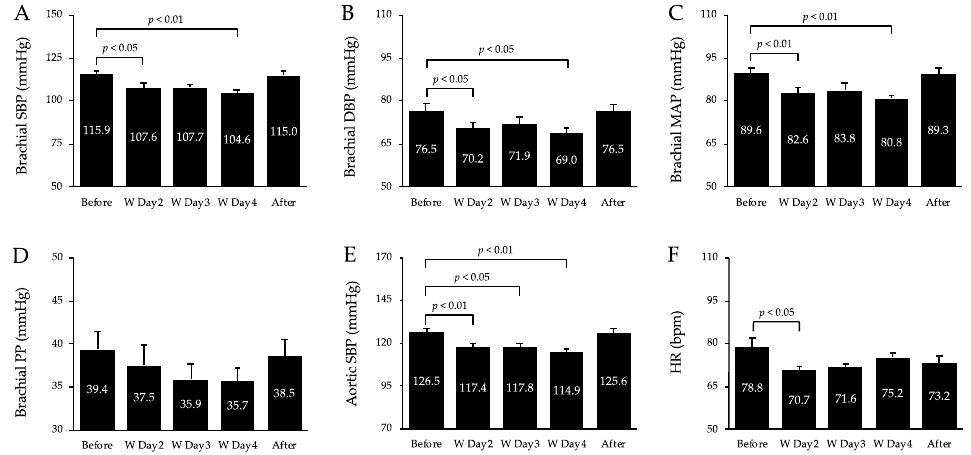
Figure 3. Changes in brachial SBP ( A ), DBP ( B ), MAP ( C ), PP ( D ), aortic SBP ( E ) and HR ( F ) before, during, and after the workcation. Values are mean ± SD. W, workcation; SBP, systolic blood pressure; DBP, diastolic blood pressure; MAP, mean arterial pressure; PP, pulse pressure; HR, heart rate.